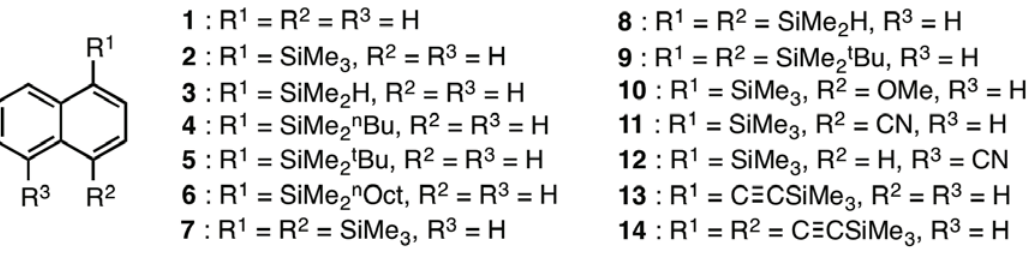
Figure 1. Structures of silyl-substituted naphthalene derivatives.